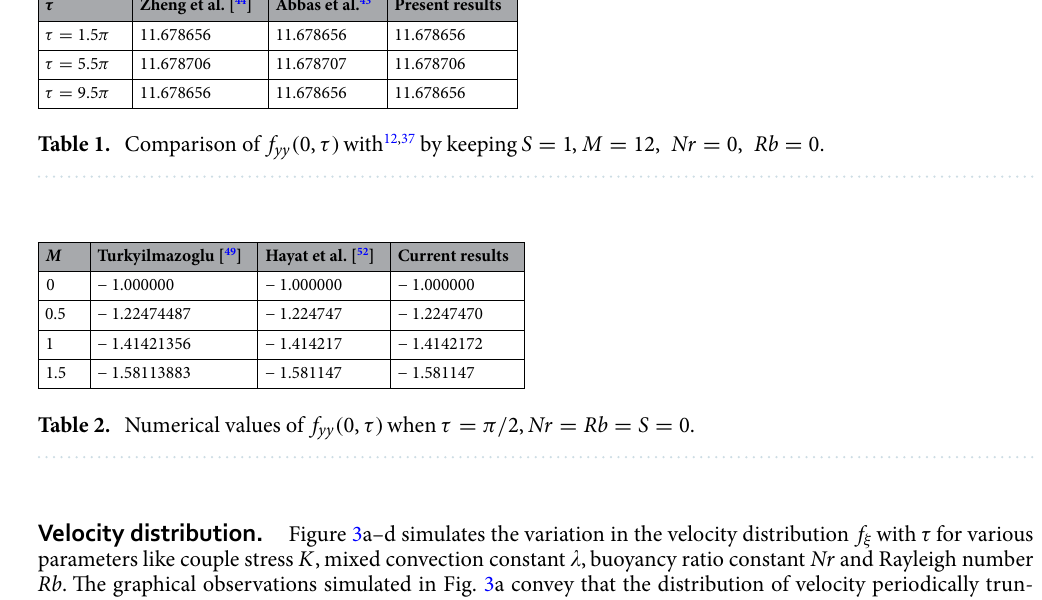
τ Zheng et al. [ 44 ] Abbas et al. 43 Present results τ = 1.5 π